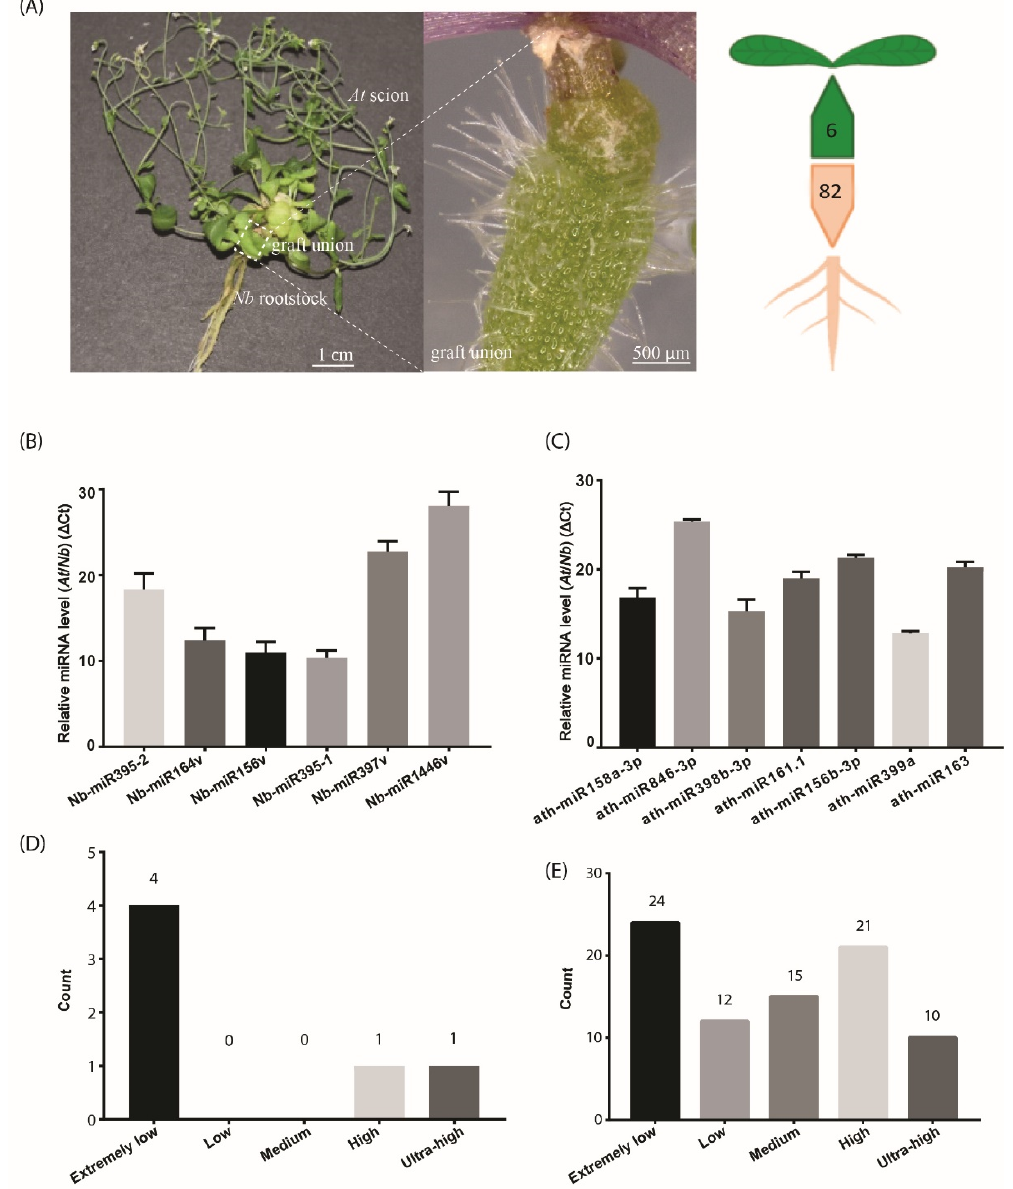
Figure 1. The number of identified mobile miRNAs in the Arabidopsis/Nicotiana interfamilial graft. ( A ) A representative At/Nb interfamilial graft showing the scion, rootstock and graft union. In total, 6 and 82 miRNAs were identified to move from root to shoot and shoot to root, respectively, in Nicotiana benthamiana and Arabidopsis thaliana . ( B ) Expression levels of the selected Nb miRNAs were determined in the At scion by quantitative real-time PCR. ( C ) Expression levels of the selected At miRNAs were determined in the Nb rootstock by quantitative real-time PCR. ( D ) Classification of expression level for the identified mobile miRNA in the scion. ( E ) Classification of expression level for the identified mobile miRNA in the rootstock. Data in ( B , C ) (mean ± standard deviation) were generated from three biological replicates and two technical replicates for each. U6 RNA was used as the internal reference. Δ Ct values were the difference between the Ct values of the selected miRNA and U6 and thus were inversely proportional to the amount of the target miRNA in the samples.